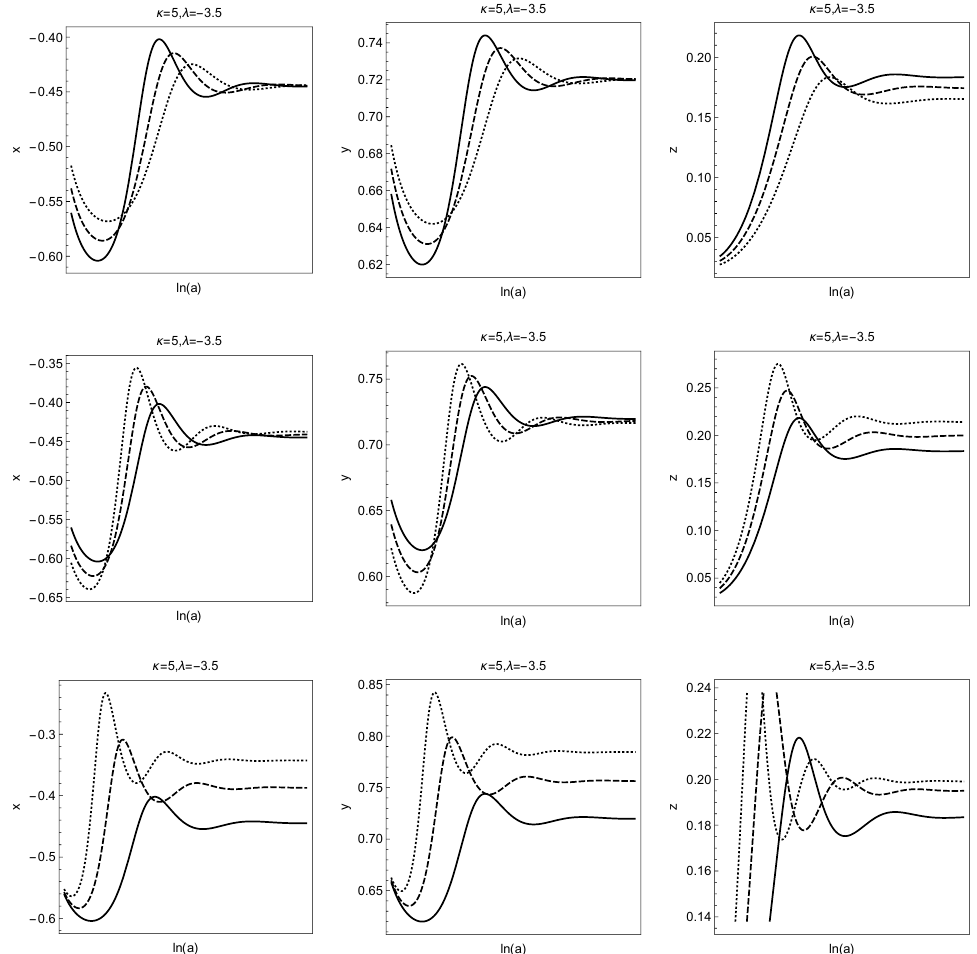
Figure 3. Qualitative evolution of the dimensionless variables ( x , y , z ) for various values of the free parameters ( ω BD , κ , λ ) . First row is for ( κ = 5, λ = − 3.5 ) , and ω BD = 0.1 (solid lines), ω BD = 0.2 (dashed lines) and ω BD = 0.3 (dotted lines). Second row is for ( ω BD , κ ) = ( 0.1,5 ) , λ = − 3.5 (solid lines), λ = − 3.6 (dashed lines) and λ = − 3.7 (dotted lines). Third row is for ( ω BD , λ ) = ( 0.1, − 3.5 ) , κ = − 3.5 (solid lines), κ = − 3.6 (dashed lines) and κ = − 3.7 (dotted